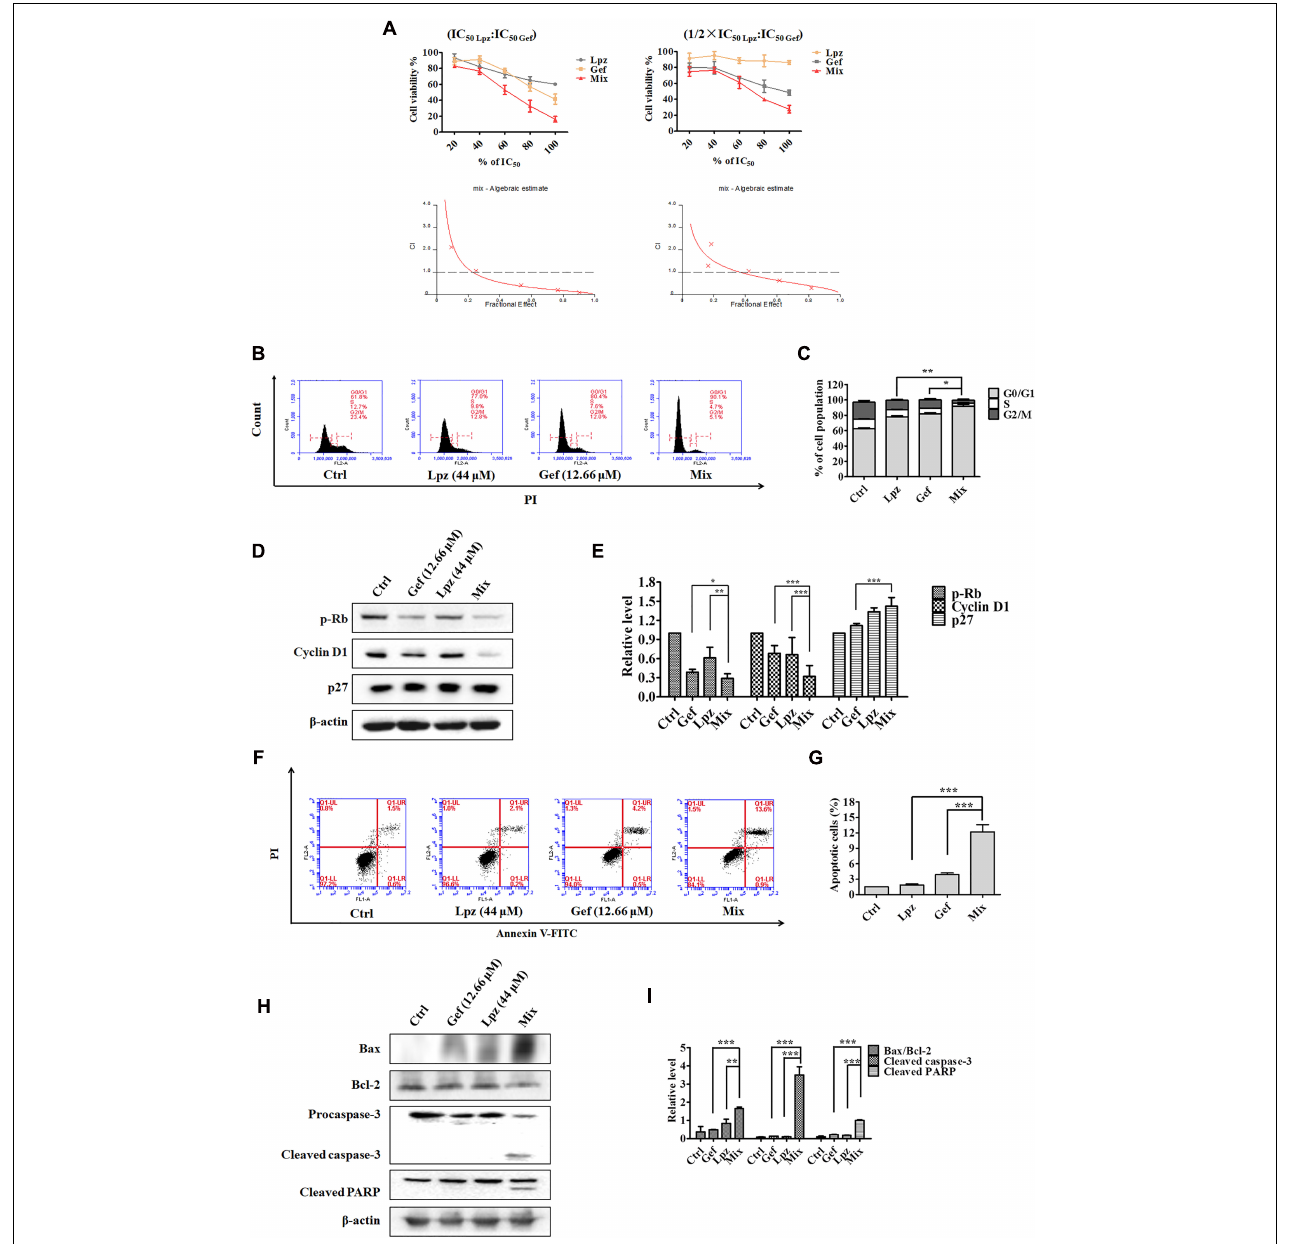
FIGURE 4 | Antitumor effect of Lpz in combination with Gef on A549 cells. (A) A549 cells were treated with Lpz and Gef (20, 40, 60, 80, or 100% IC 50 values of each drug), either alone or in combination for 48 h. In particular, in the combination groups, cells were pre-treated with Lpz for 2 h and were then treated with Gef for 48 h. Two fixed ratios of IC 50 lansoprazole :IC 50 gefitinib and 1/2 × IC 50 lansoprazole :IC 50 gefitinib were used. The combined effect was analyzed using CalcuSyn software, and the resulting CI-Fa plots are shown for A549 cells. (B) Lpz combined with Gef obviously arrested the A549 cell cycle in G0/G1 phase compared with either Lpz or Gef alone. (C) Quantification of the results in panel (B) . (D) Identification of the G0/G1-related proteins by Western blot. (E) Quantification of the results in panel (D) . (F) Lpz in combination with Gef facilitates A549 cell apoptosis. (G) Quantification of the results in panel (F) . (H) Identification of the apoptosis-related proteins by Western blot. (I) Quantification of the results in panel (H) . Data shown are the mean ± SD of three independent experiments. *: p < 0.05, **: p < 0.01, and ***: p <